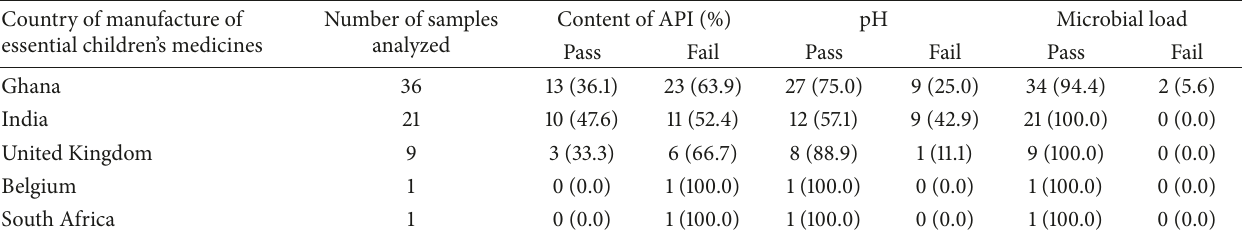
Table 6: Summary results of the quality of sampled essential children’s medicines based on country of manufacture. Country of manufacture